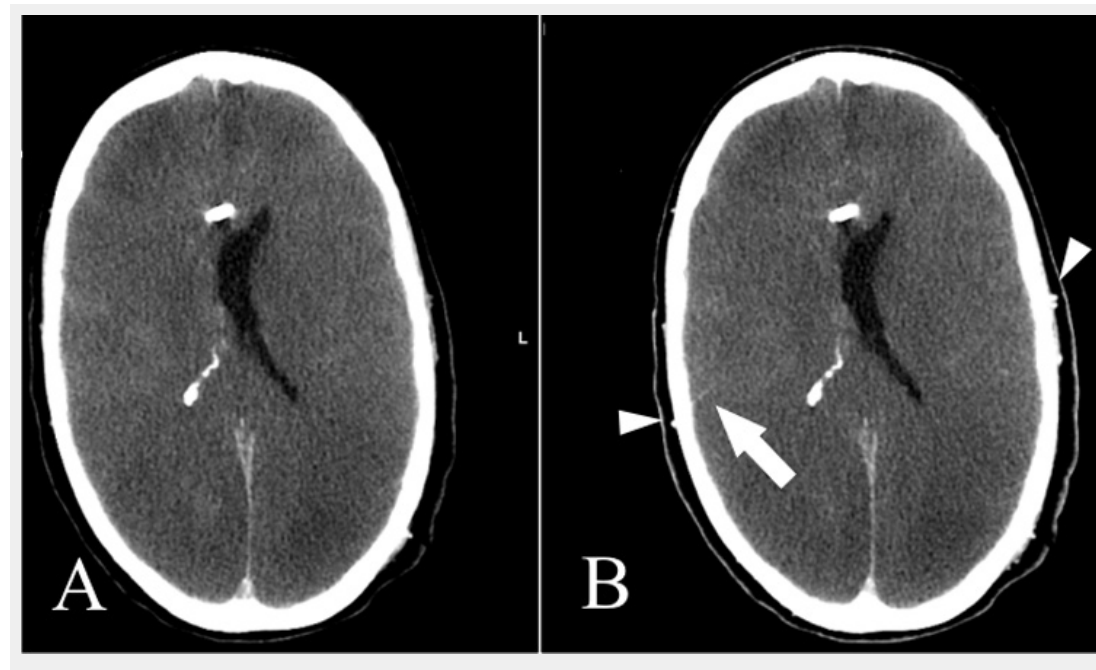
Figure 3 Non-contrast CT (A) and venous-phase CT (B): Opacification of the superficial temporal artery indicates sufficient contrast injection (Arrowheads). Note also opacification of an M4 segment artery on the right, a marker of some residual cortical perfusion. In this case, circulatory arrest could not be